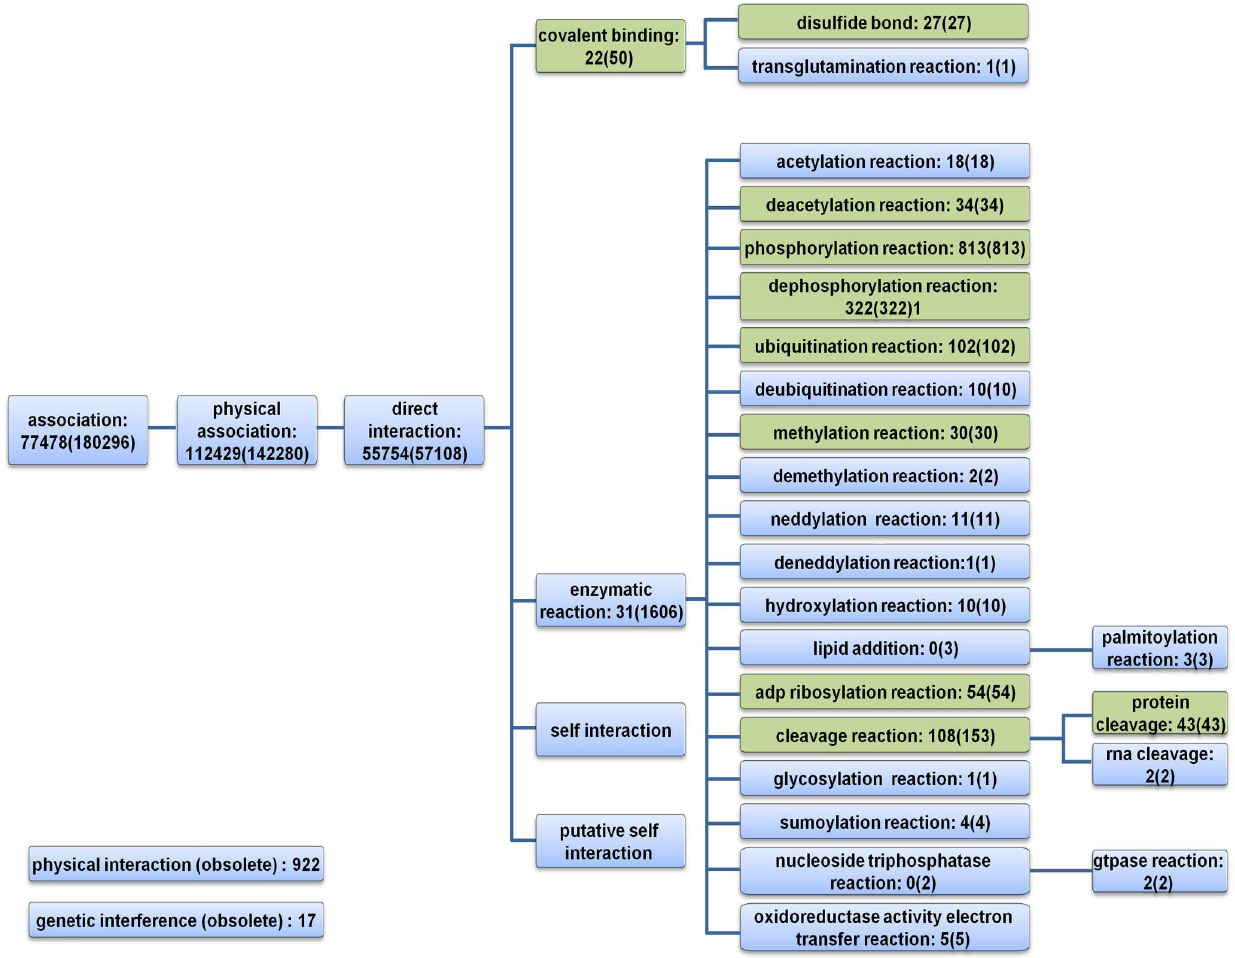
Figure 1. Hierarchical view of psi-mi interaction types extracted from PPIs records. For every interaction type we state the number of PPIs directly associated to the type. The number of PPIs associated with the type and its descendants in the ontology is given in parenthesis. Interaction types predicted using logistic regression are highlight in green.